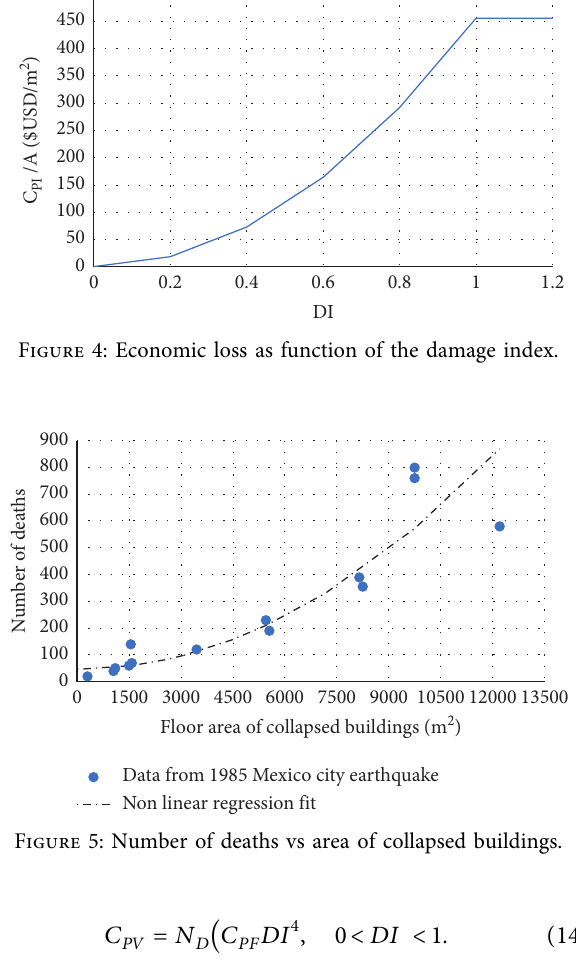
Table 3 are the parameters for beams; b: width, h: depth, Ase: longitudinal reinforcement inferior at the end region of beam, Ase’: longitudinal reinforcement superior at the end region of beam, Asm: longitudinal reinforcement inferior at